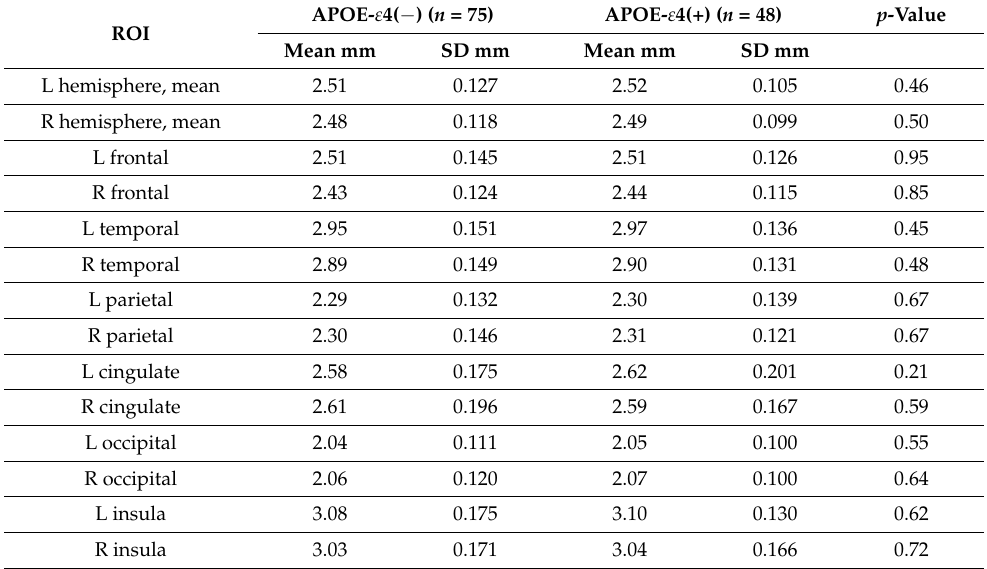
Table 6. APOE ε 4 status on the mean values of neuroanatomic thickness measurements per